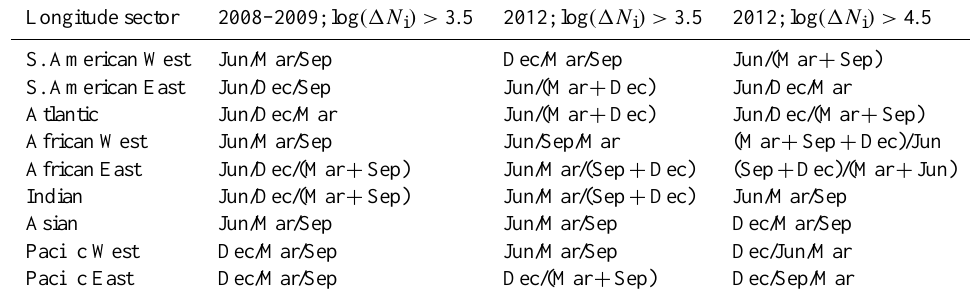
Table 3. Seasonal (minimum/maximum/second greatest) detrended probability for each longitude sector from the data of Fig. 10. Longitude sector 2008–2009; log (1N i ) > 3 . 5 2012; log (1N i ) > 3 .